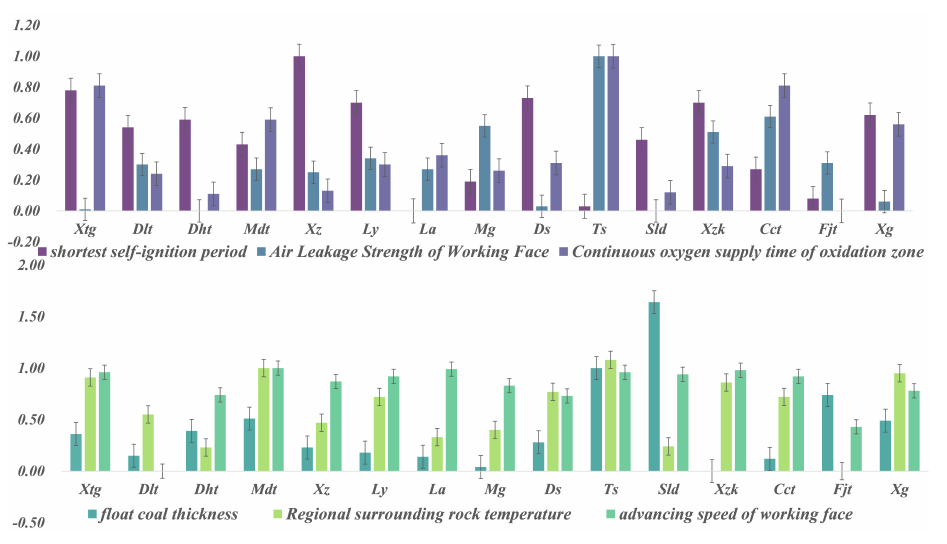
Figure 4. Fifteen typical coal mine data displayed in a